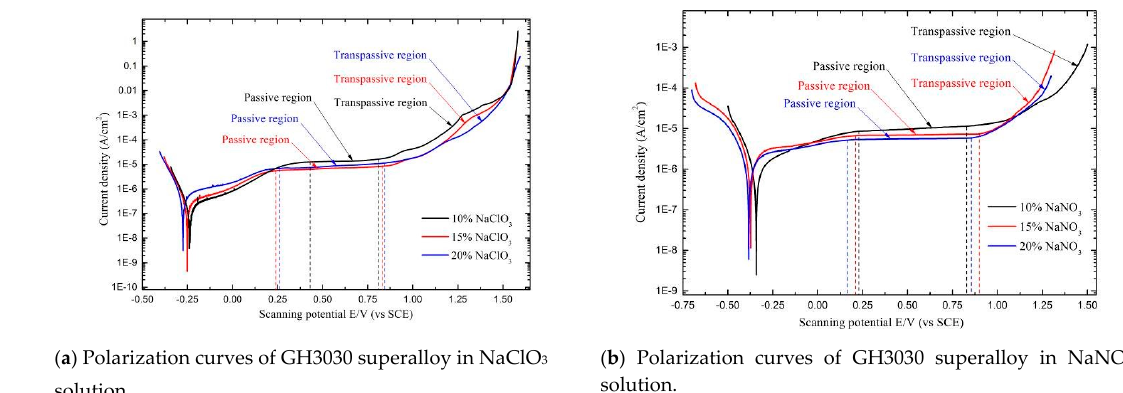
Figure 6. Polarization curves of GH3030 superalloy in different electrolyte environments.